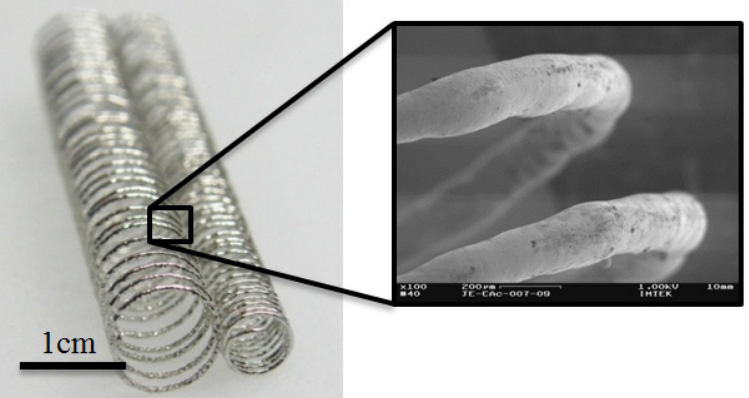
Figure 18. Picture of two coils (Diameter 10 mm/6 mm) printed at 350 °C metal temperature with close up view (SEM-picture) of the